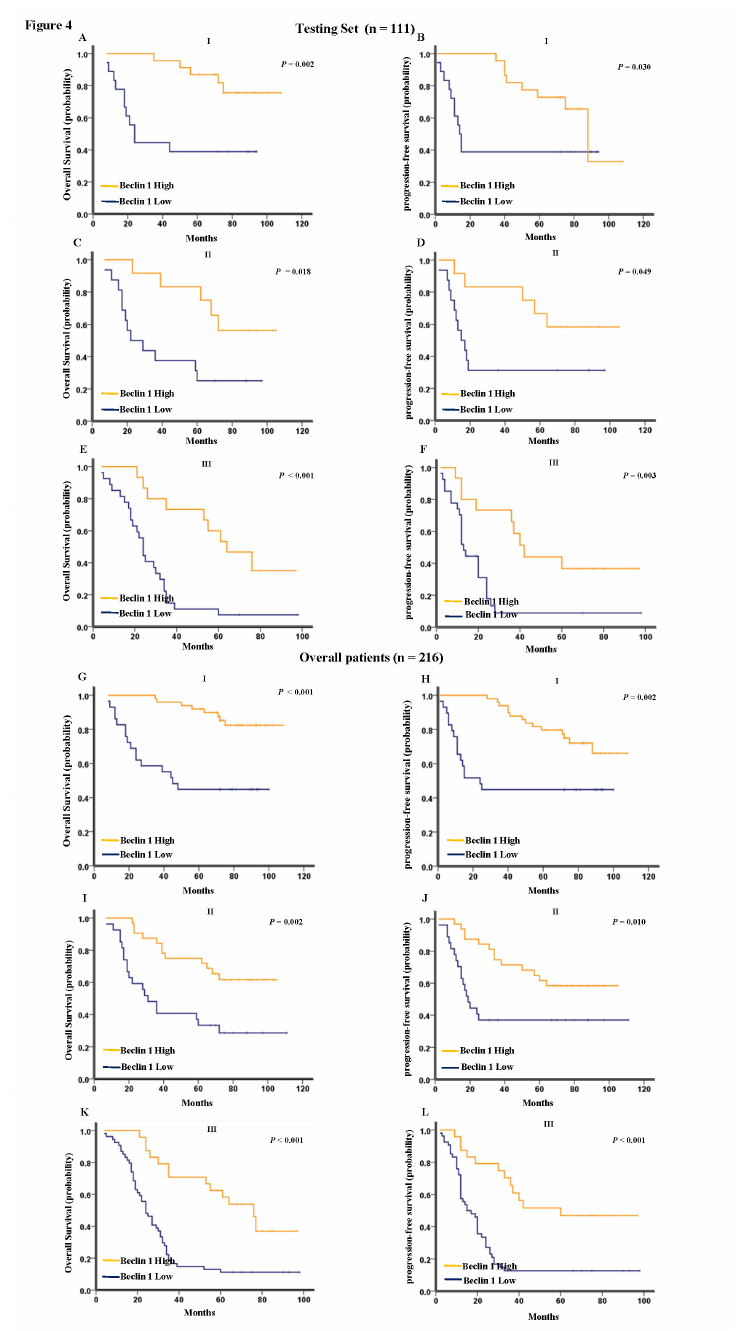
Figure 4. Kaplan-Meier survival analysis of Beclin 1 expression in subsets of NSCLC patients. (A) Probability of overall survival and (B) progression-free survival of NSCLC patients with stage i in the testing set: low expression, n = 18; high expression, n = 23. (C) Probability of overall survival and (D) progression-free survival of NSCLC patients with stage ii in the testing set: low expression, n = 16; high expression, n = 12. (E) Probability of overall survival and (F) progression-free survival of NSCLC patients with stage iii in the testing set: low expression, n = 27; high expression, n = 15. (G) Probability of overall survival and (H) progression-free survival of NSCLC patients with stage Ⅰ in the the overall patient cohort: low expression, n = 29; high expression, n = 50. (I) Probability of overall survival and (J) progression-free survival of NSCLC patients with stage ii in the the overall patient cohort: low expression, n = 27; high expression, n = 32. (K) Probability of overall survival and (L) progression-free survival of NSCLC patients with stage iii in the the overall patient cohort: low expression, n = 54; high expression, n = 24. doi: 10.1371/journal.pone.0080338.g004 PLOS ONE |